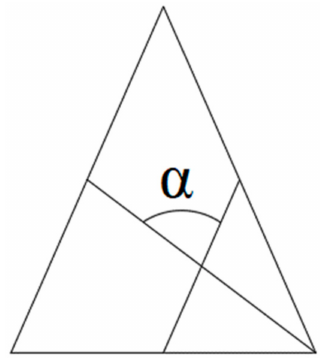
Figure 3. Definition of skew. Source: HyperMesh meshing control guide.